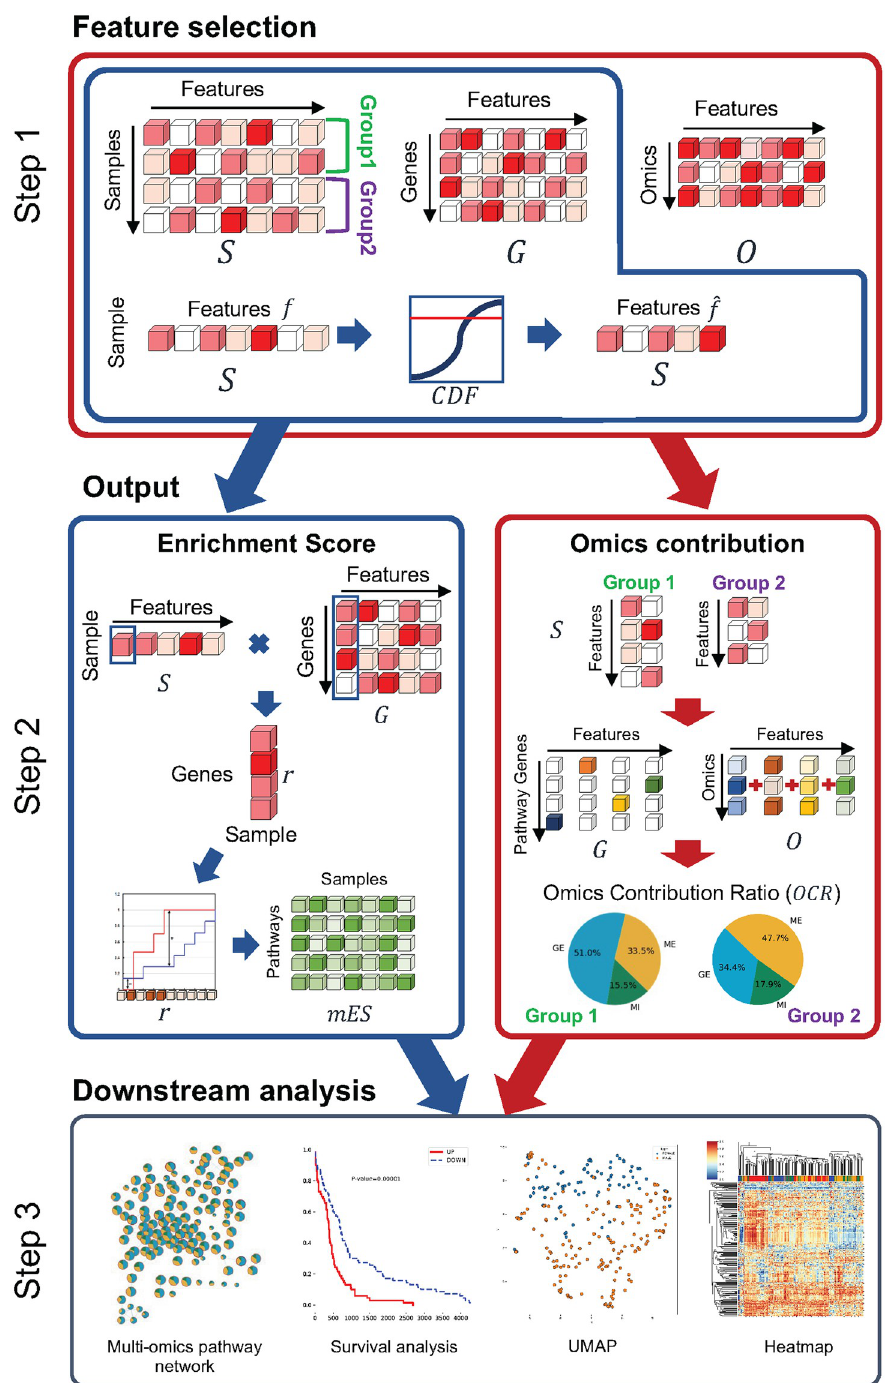
Fig 3. The three step workflow of MOPA for computing mES and OCR. The MOPA process is carried out in three steps. Step 1 performs feature selection to remove features with weak multi-omics information. Step 2 computes the mES and OCR based on the selected features in an independent manner. Step 3 performs biological interpretation that includes the construction of group specific pathway-to-pathway networks, survival analysis, UMAP and heatmap